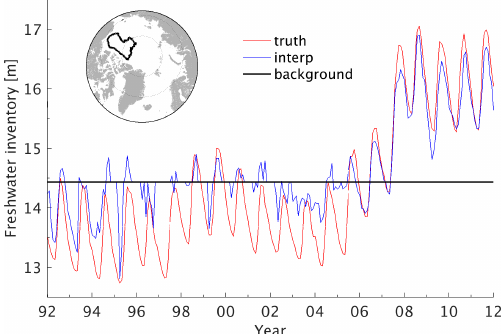
Figure 13. Mean freshwater inventory (in meter) in the Canadian Basin (enclosed by the black line in the top subplot) from the background state, the “truth”, and the optimal interpolation recon- structed state (see legend).